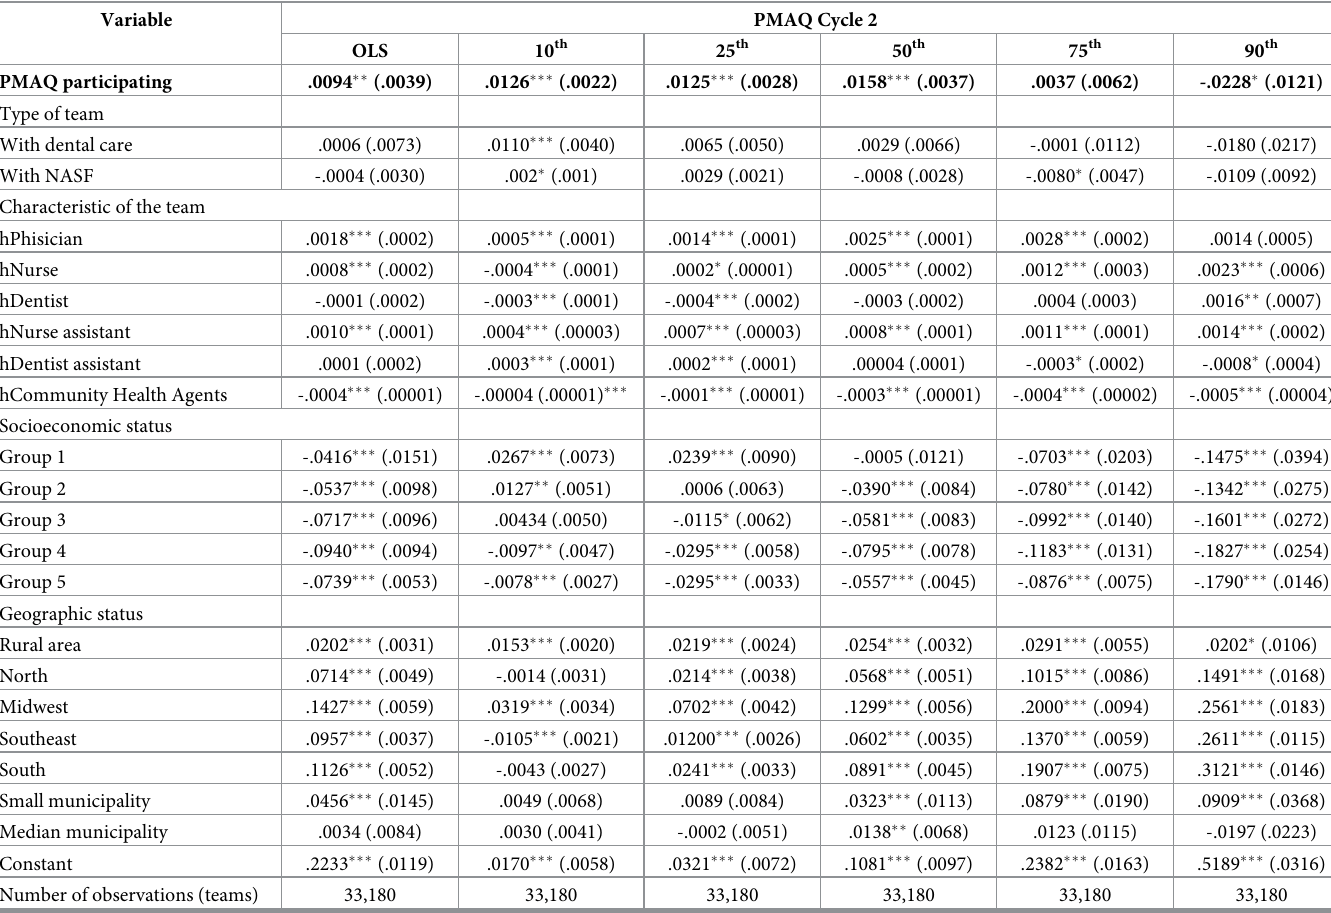
Table 4. Results from OLS and QR models for the number of physician consultations for children under 1 year old in the 2 nd cycle of PMAQ, Brazil.